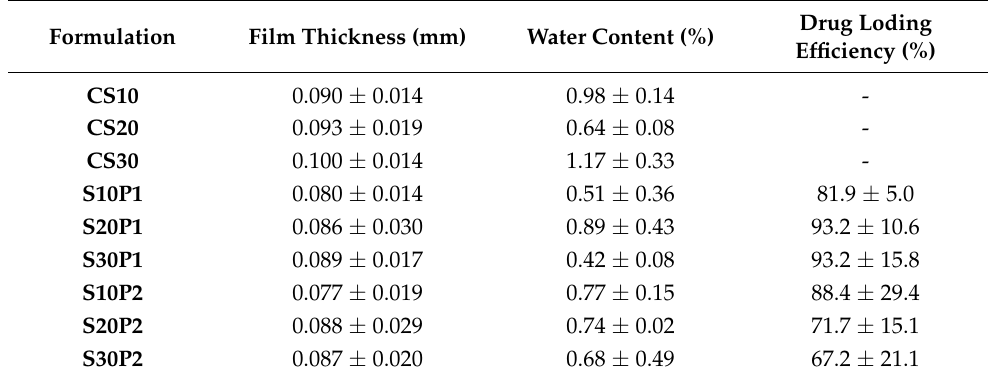
Table 1. Average thickness (n = 10), water content and drug loading efficiency (n = 3) of all rice starch films (mean ±